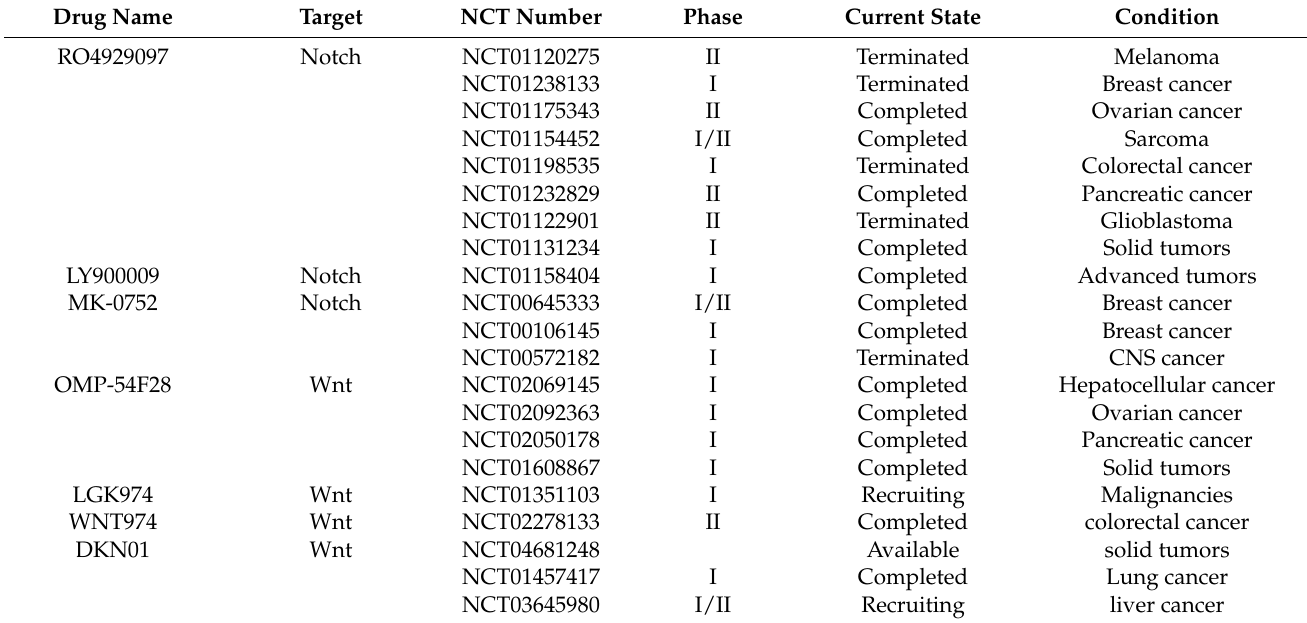
Table 3. Some agents targeting CSCs-related signal pathways which were evaluated in clinical trials. Drug